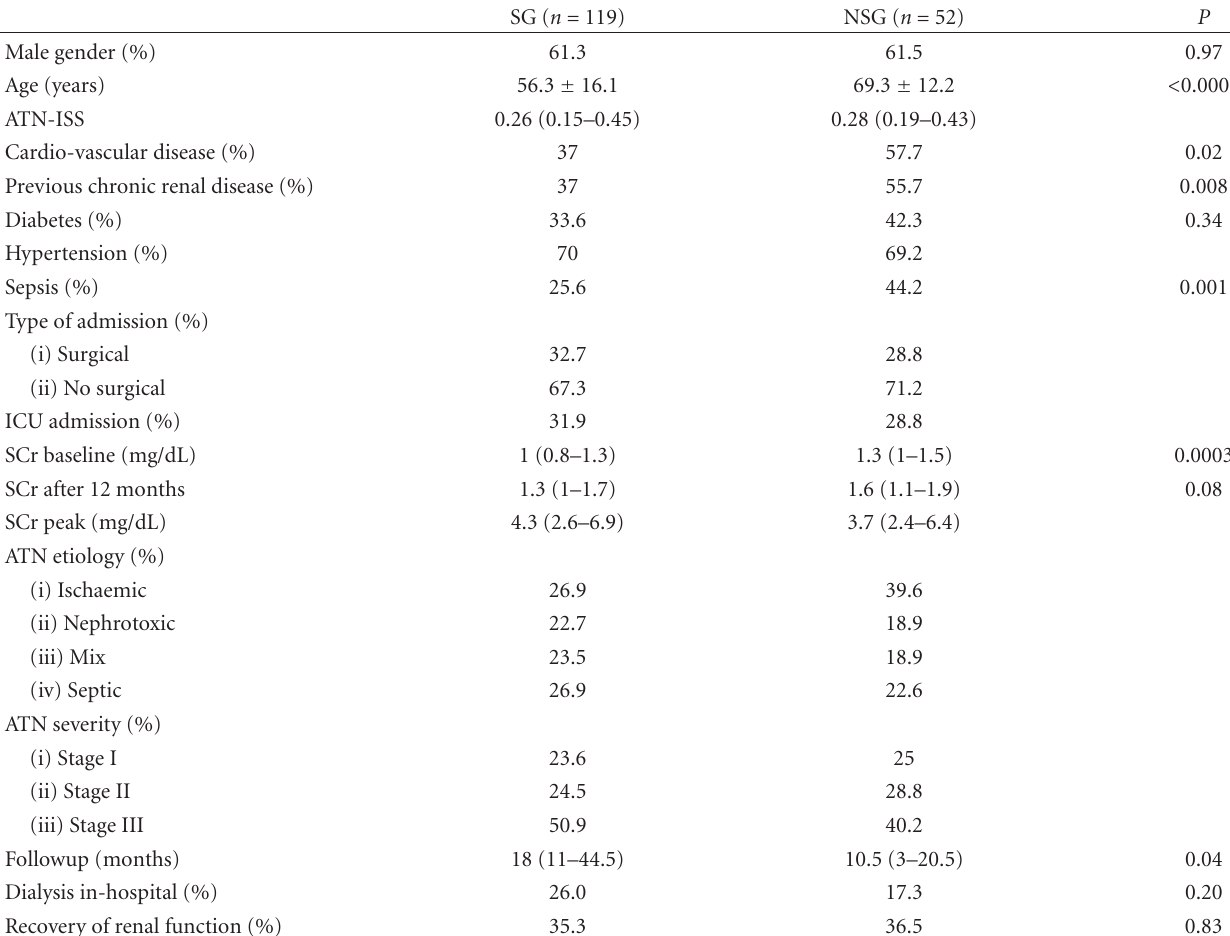
Table 2: Comparative analysis of survivor (SG) and non-survivor (NSG) patients after an episode of ATN according to clinical and laboratory characteristics and outcome.